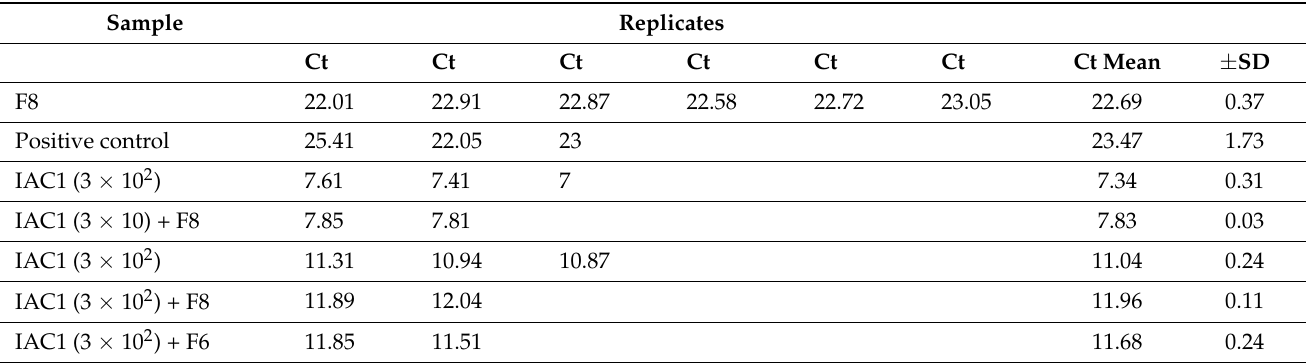
Table 4. Average cycle thresholds (Ct) and standard deviation from the positive sample (F8), positive control sample, IAC 1 at two different dilutions, and IAC 1 at different dilution with F8 or F6